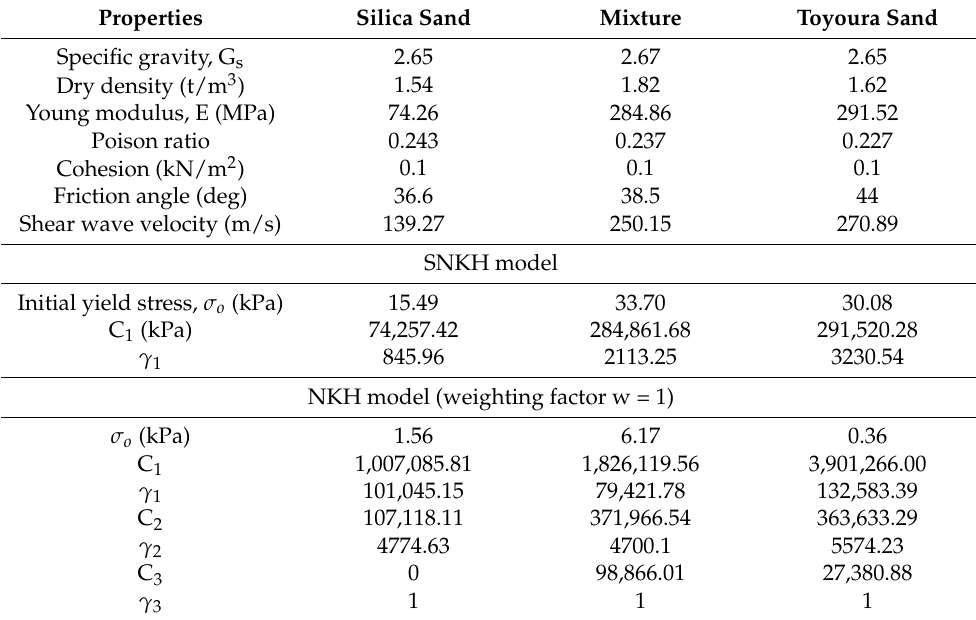
Table 1. Soil properties and parameters of SNKH and NKH